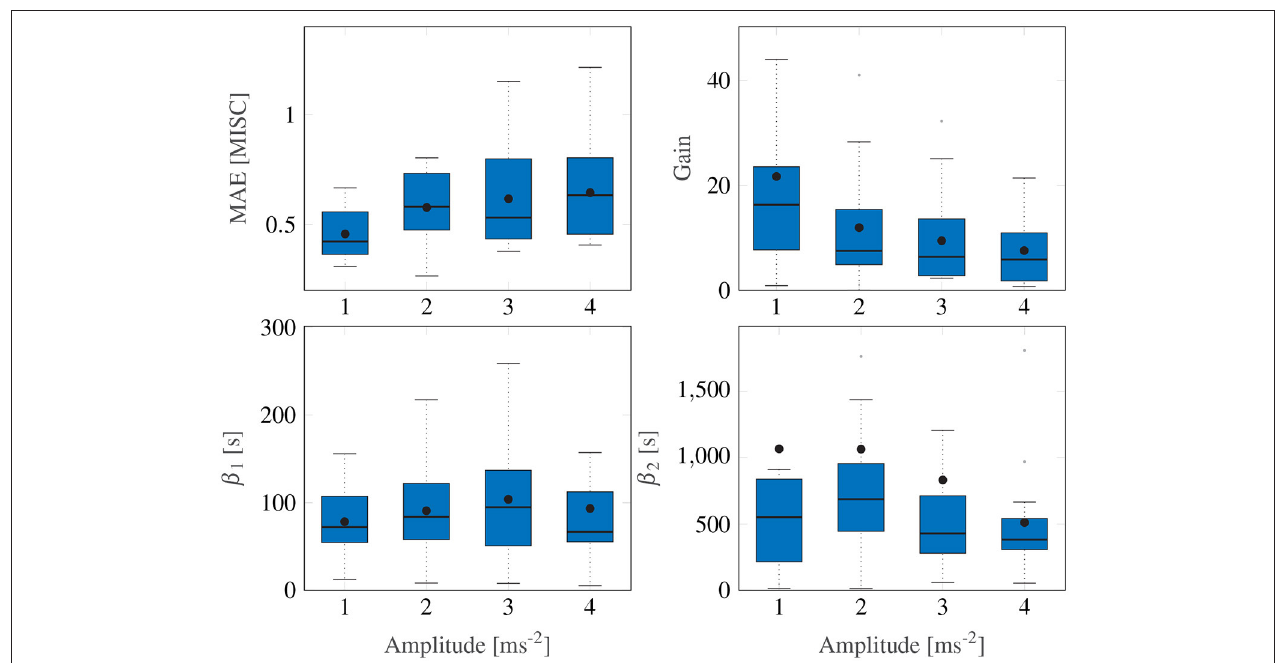
FIGURE 5 | Box plots showing the mean absolute error, the gain and the two time constants of the Session Fit, Unit Power model variation. The Box plot is in standard form, with the center black line indicating the median, the dots indicating the means, and the sides of the box indicating the quartiles. Some outliers are above the maximum y -value limits chosen for the respective subplot.